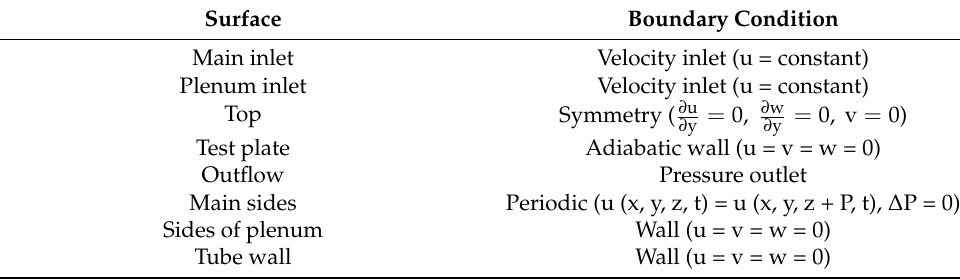
Table 1. Boundary conditions of the computational fluid dynamics (CFD)